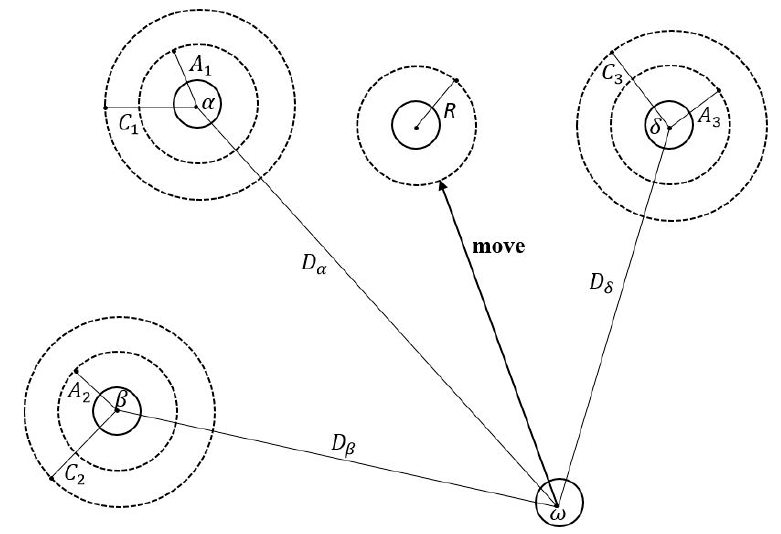
Figure 7. The position update process for grey wolves.